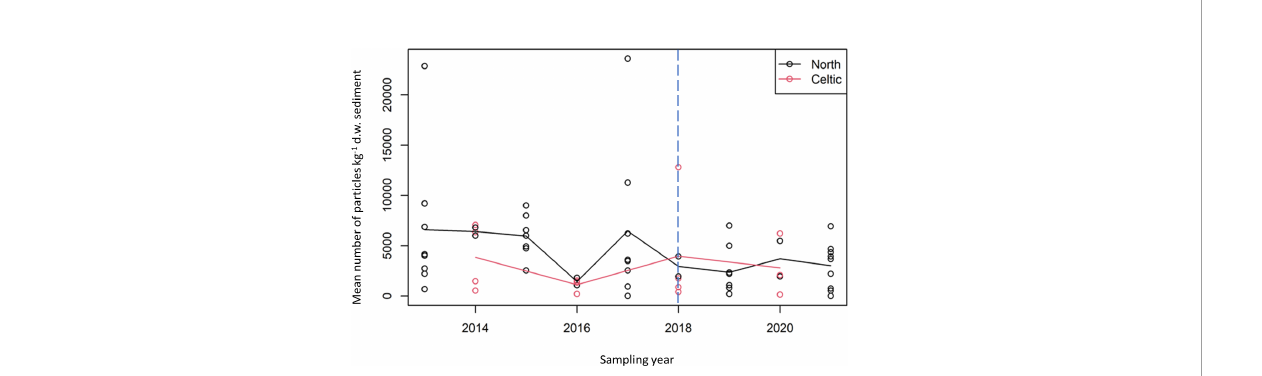
FIGURE 6 Mean number of particles kg -1 d.w. sediment plotted against year for the Greater North Sea (black) and Celtic Seas (red) survey data. Also shown are lines linking the means of the square root counts for each of the two surveys. Blue line indicates change in sampling method from the use of archive samples to dedicated microplastic